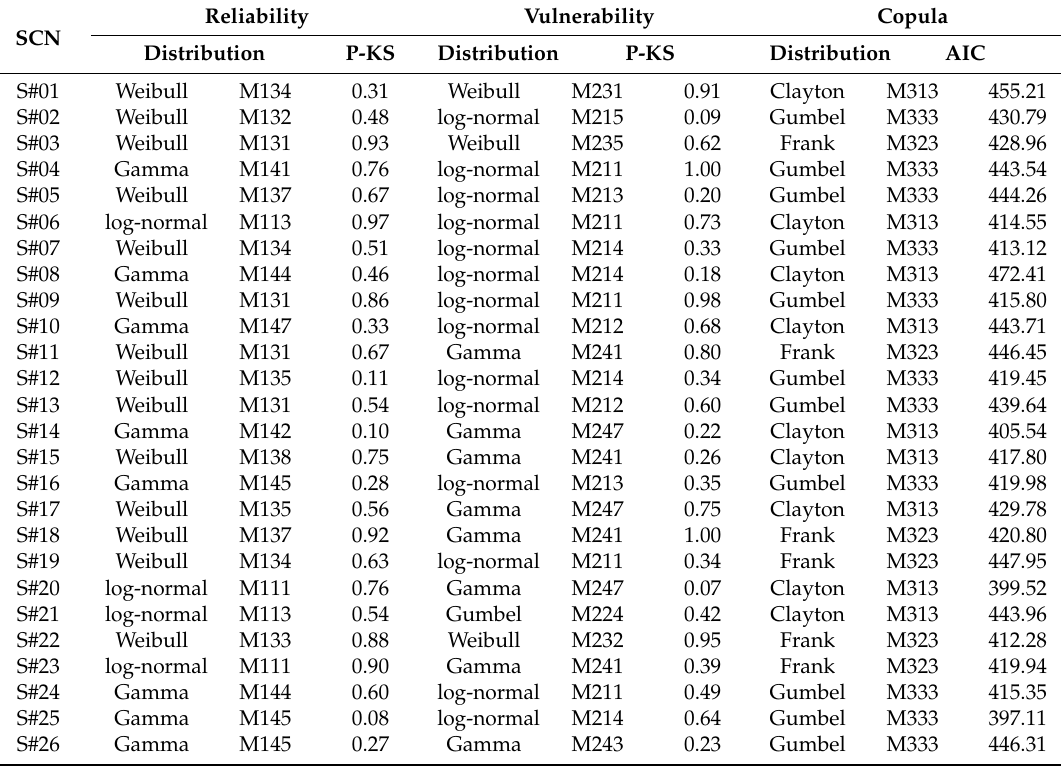
Table 4. Time-dependent copula model selection of each